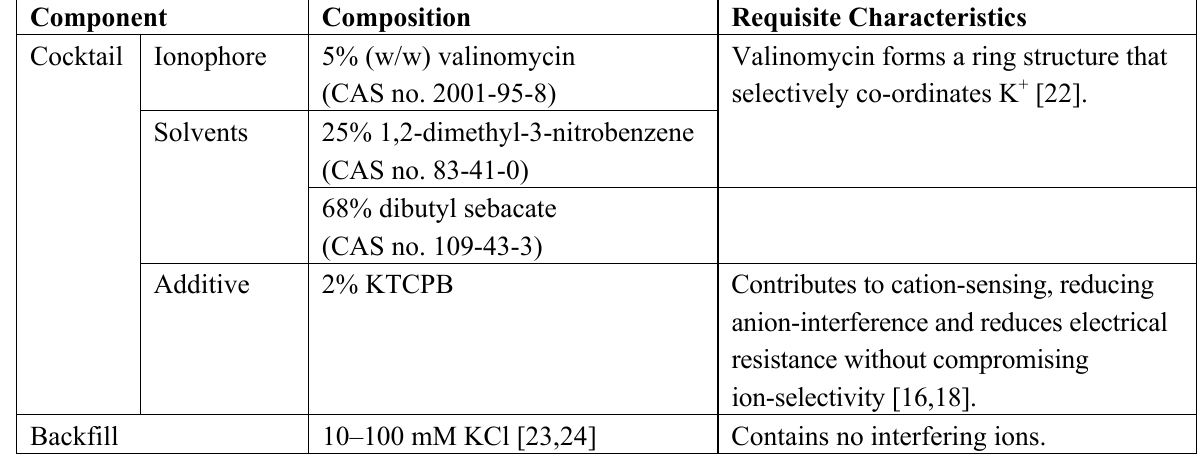
Table 3. The composition and components of K + -selective ionophore I cocktail A (Sigma cat. no. 60031). Further details are provided at The Sensor Application Portal hosted